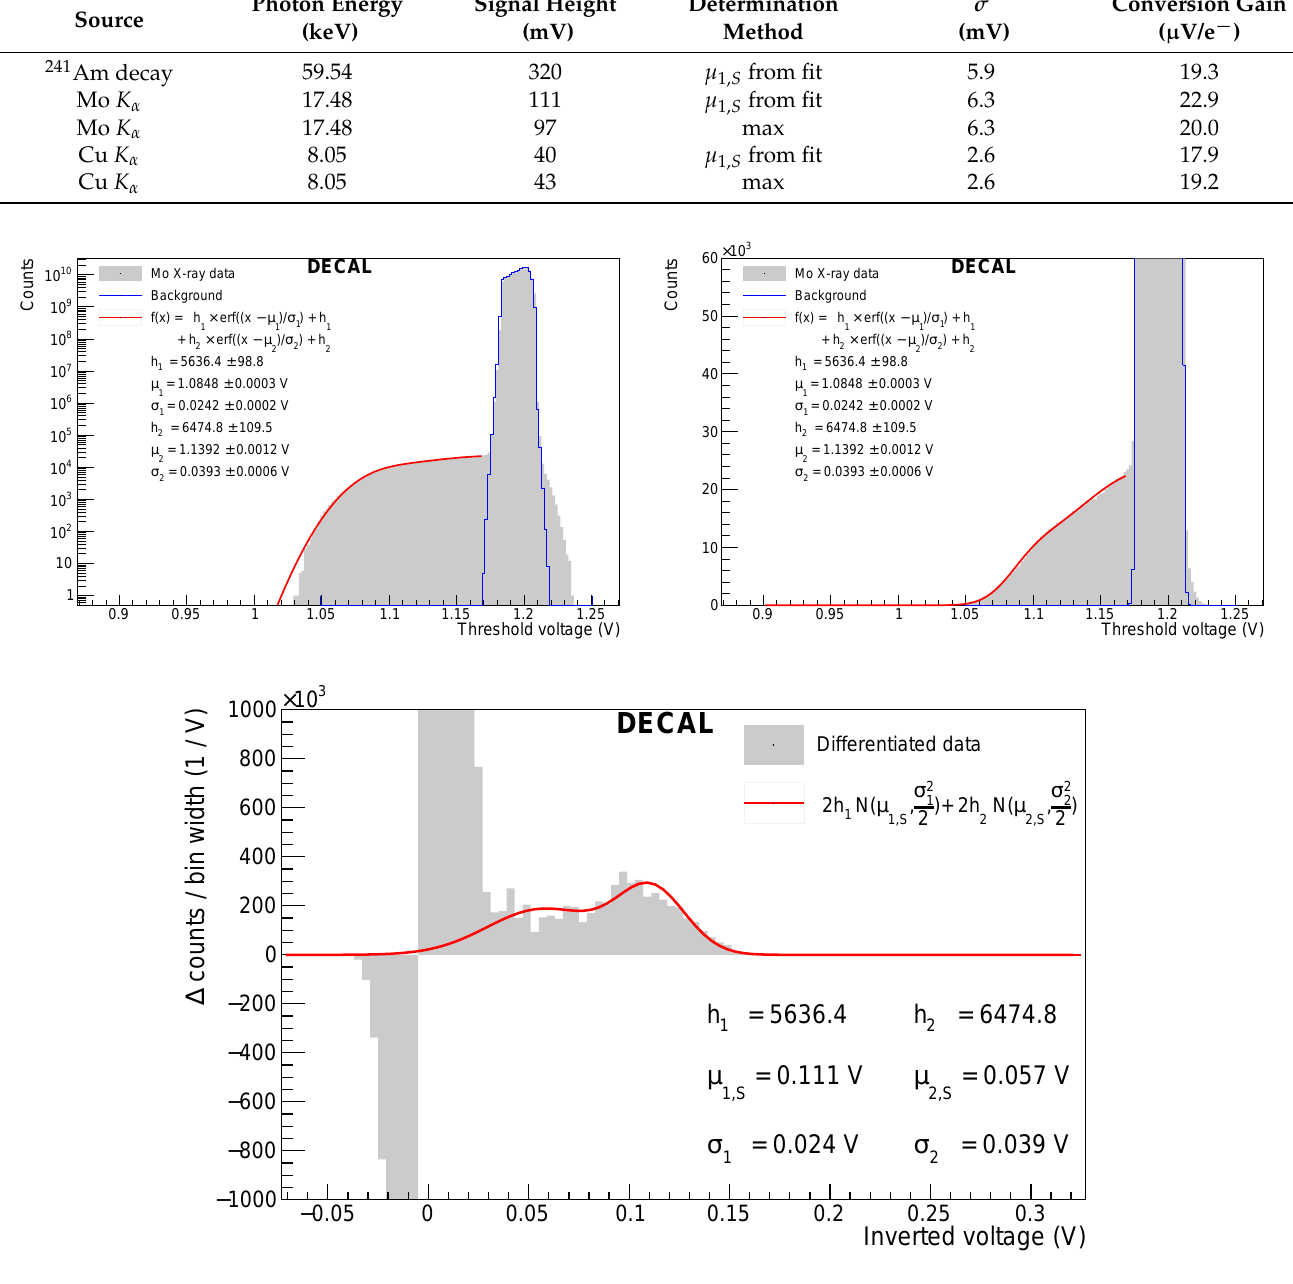
Figure 20. Threshold scan with the DECAL chip under Mo X-ray fluorescence on logarithmic ( top left ) and linear scale ( top right ) and their differentiation ( bottom ). The differentiation of the threshold scan data is here performed with a bin width of 4 mV due to the larger threshold voltage range. Background data measured when the X-ray source is turned off are indicated by the blue